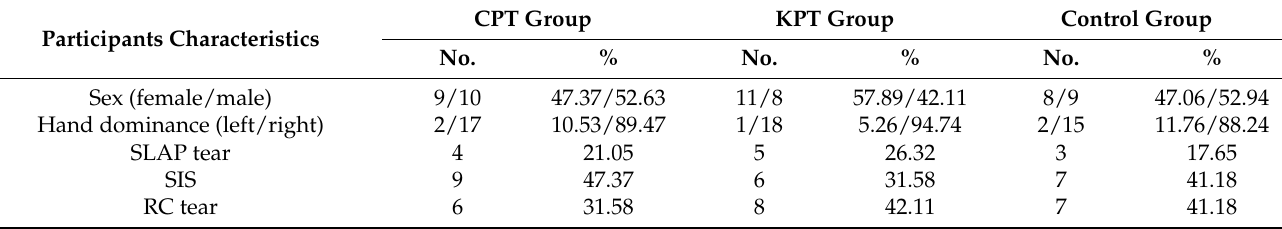
Table 2. Participants clinical information, sex and manual